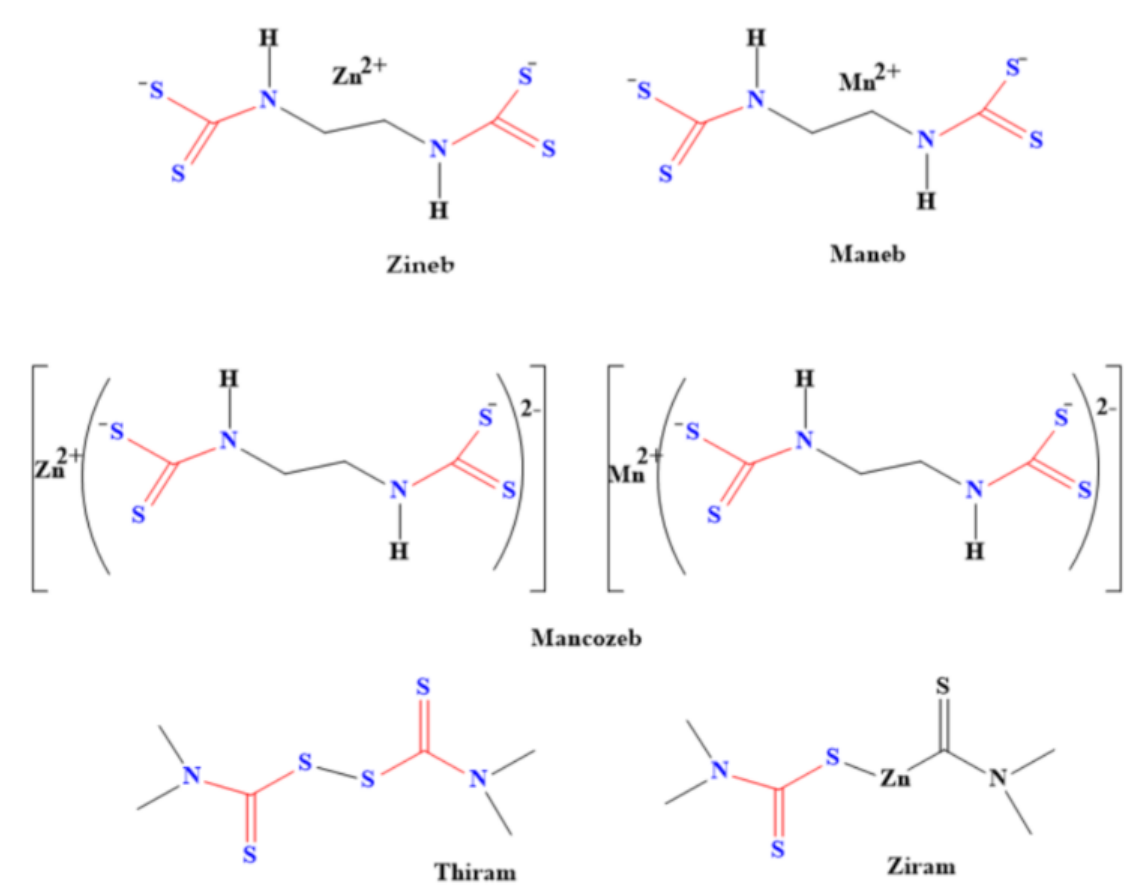
Figure 7. Examples of dithiocarbamate